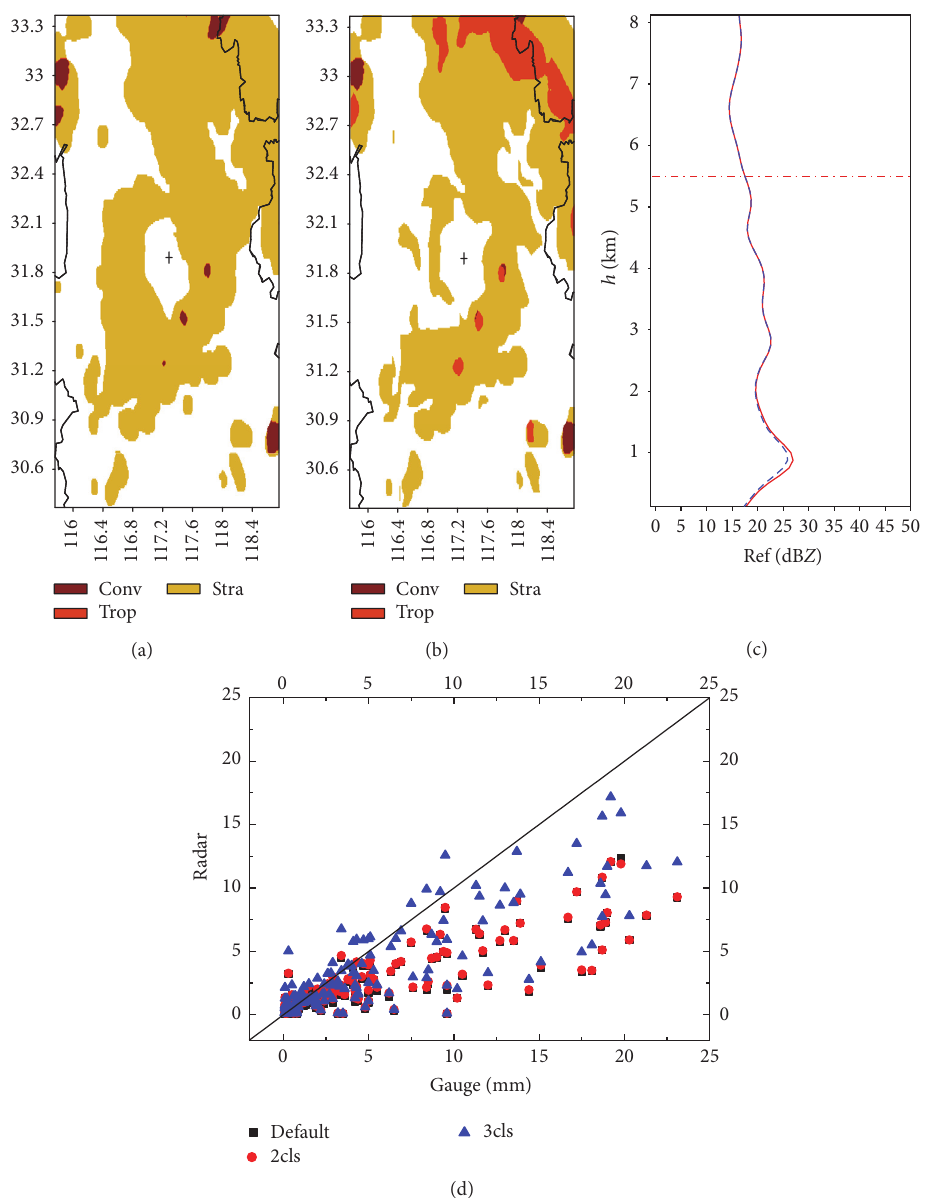
Figure 7: Hefei heavy rain (valid at 0800 UTC, July 22, 2009). (a) Results of the FL algorithm (the abscissas represent longitude, the vertical axis represents latitude, the “+” sign represents the radar location, and the colors of “Conv” and “Stra” represent convective and stratiform rainfallregions,resp.).(b)Distributionoftheconvective,stratiform,andtropicalrainfall.(c)AveragedstratiformVPR(theabscissasrepresent the value of reflectivity in dB Z , the vertical axis represents the altitude in km, the long dashed line is the 0 ∘ C isotherm altitude, the red solid line is the VPR before bright band correction, and the blue short dashed line is the VPR after bright band correction). (d) Scatter plot of gauge versus radar-derived 1-h accumulated precipitation (the abscissas represent gauge results in mm, the vertical axis represents radar-derived 1-h accumulated precipitation in mm, and the diagonal line represents the ideal